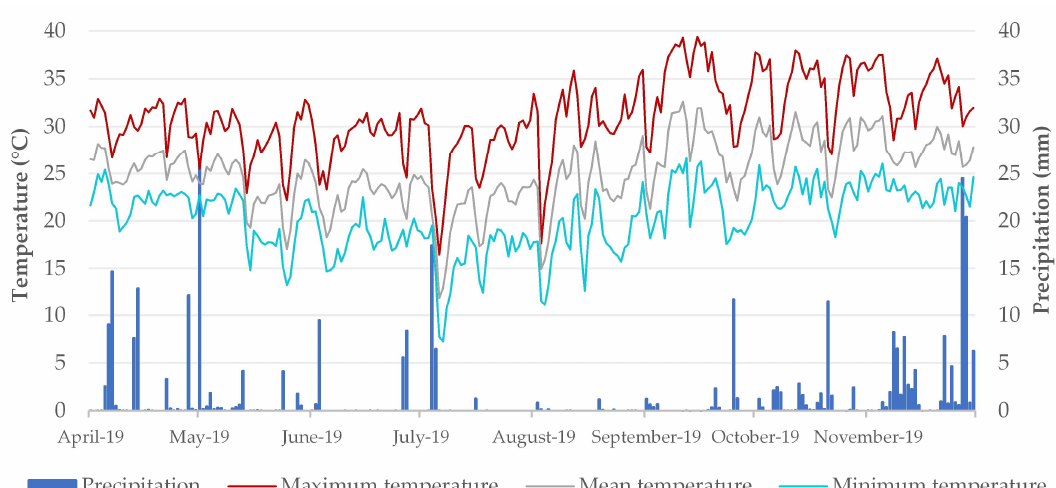
Figure 2. Daily meteorological data obtained from the ECMWF (European Centre for Medium-Range Weather Forecasts)/Copernicus Climate Change Service, considering the period from April to November 2019 for the study area.